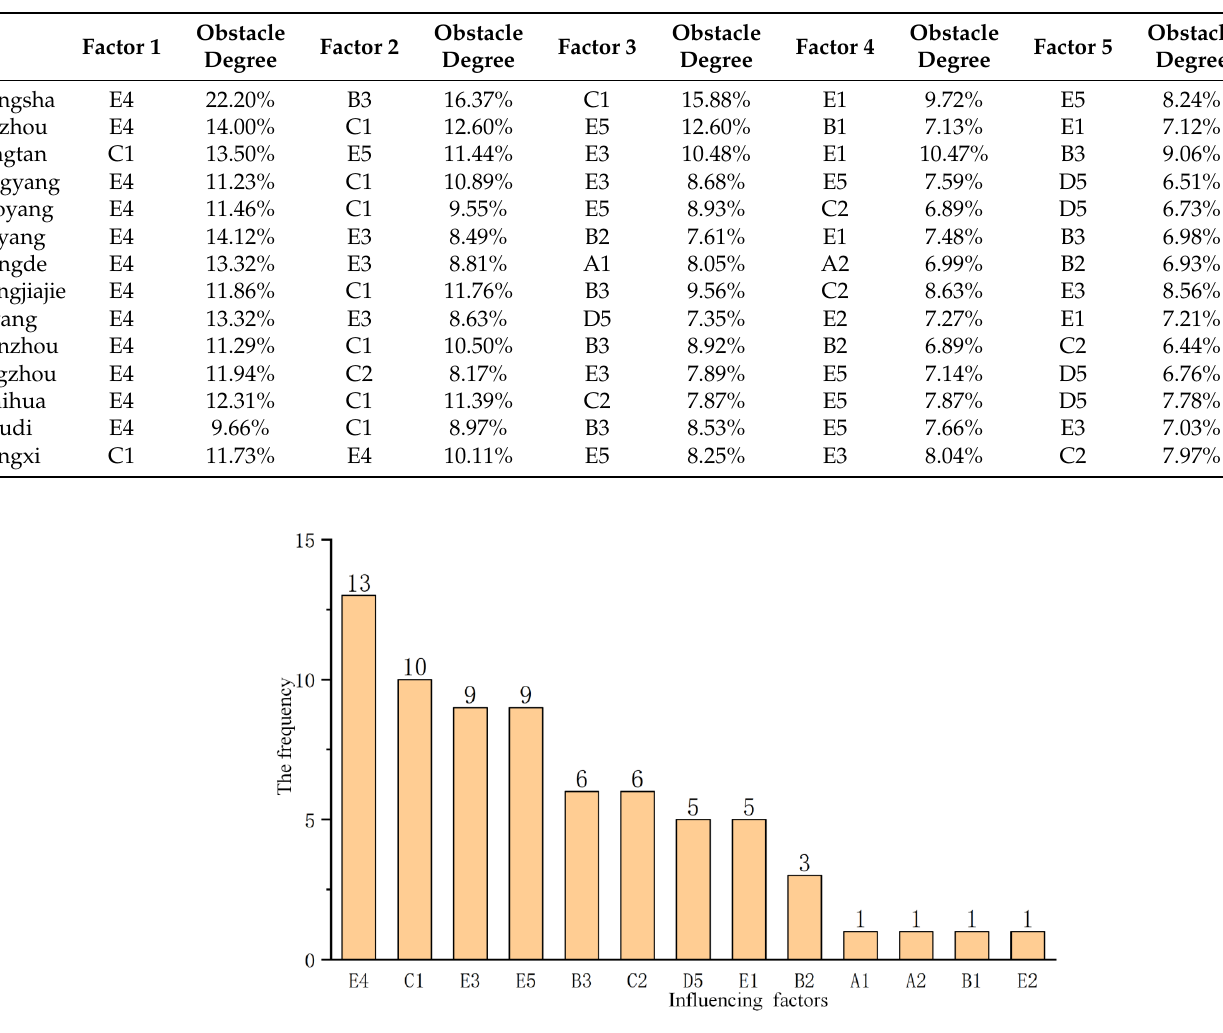
Table 6. The main obstacle factors and the degree of obstruction in index layer of each city in Hunan Province.